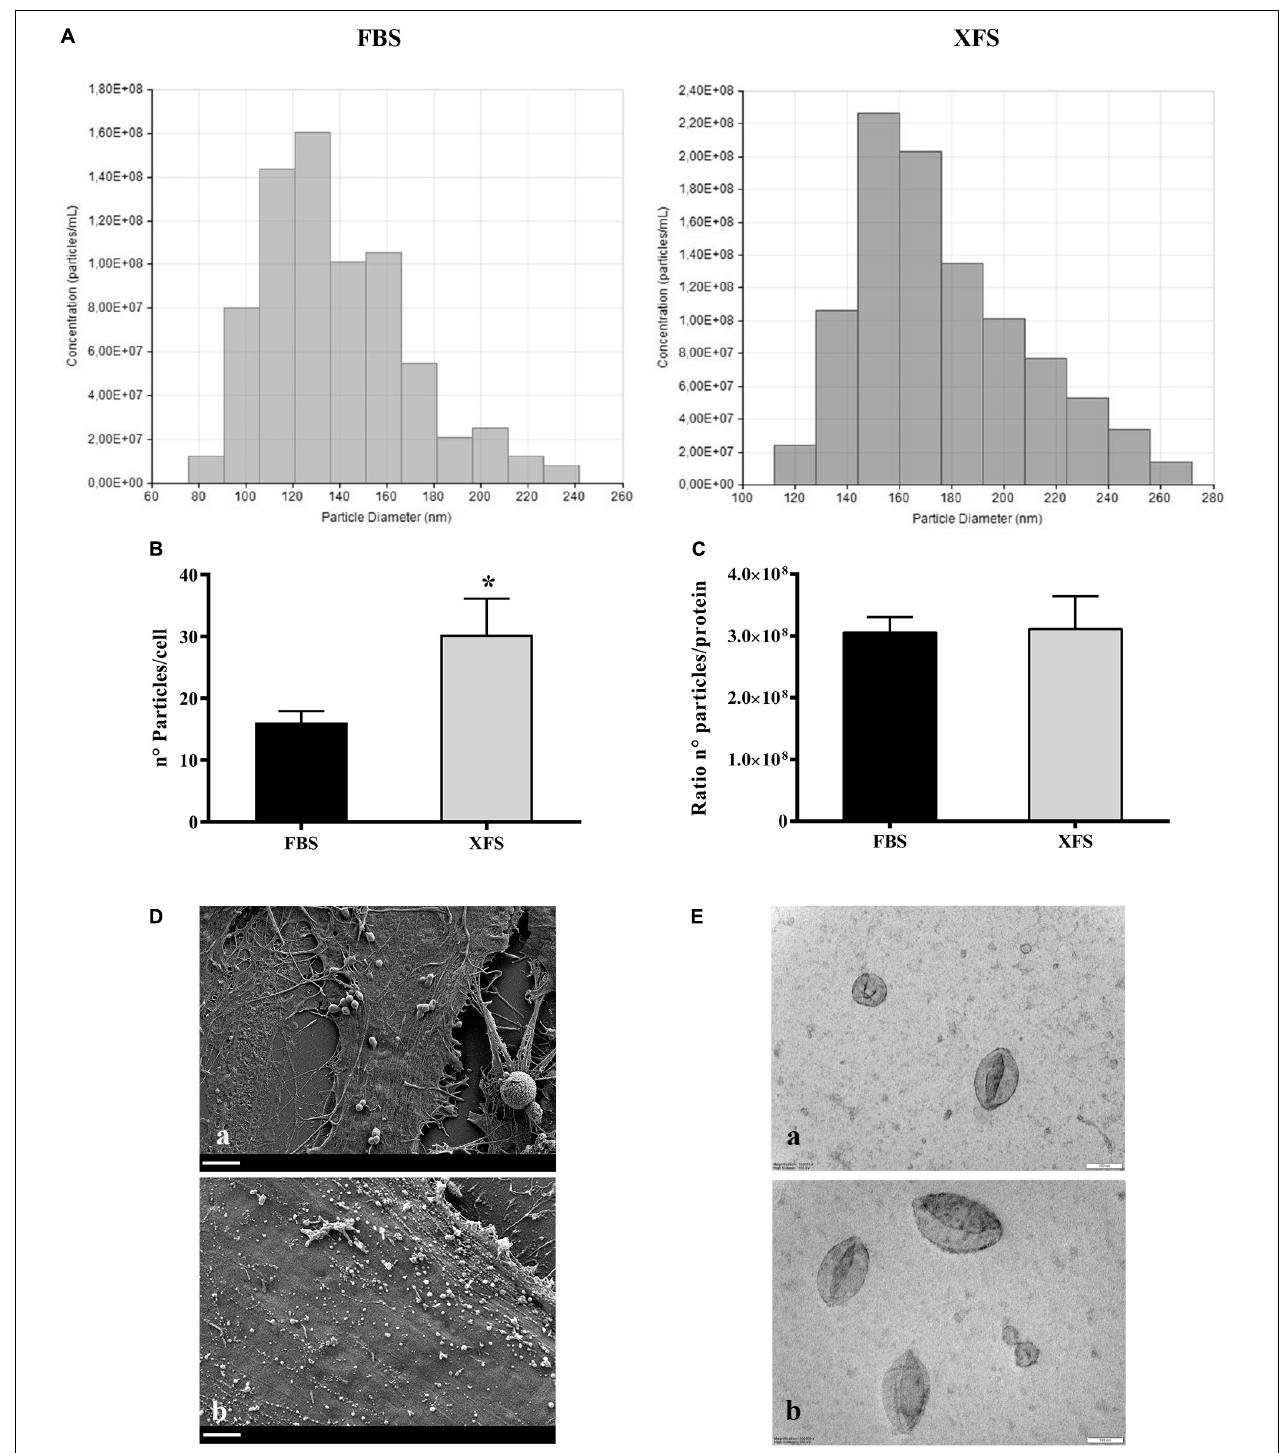
FIGURE 6 | Size distribution and morphological analysis of EVs derived from HBMSCs cultured in FBS- or XFS-containing medium. (A) TRPS analysis measuring size distribution of FBS-hBMSC-EVs and XFS-hBMSC-EVs. (B) TRPS analysis measuring the number of particles produced by FBS-hBMSCs and -XFS-hBMSCs expressed as number of particles/cell. Data are shown as mean ± SD and are representative of three independent experiments. * P < 0.05, t -test. (C) Number of particles/protein ratio for a single cell. Data are shown as mean ± SD. (D) SEM micrographs of FBS- (a) and XFS-hBMSCs (b) after 72 h of starvation. Scale bar = 2 µ m. (E) TEM micrographs of FBS- (a) and XFS-hBMSCs-derived (b) isolated EVs. Scale bar = 100 nm.